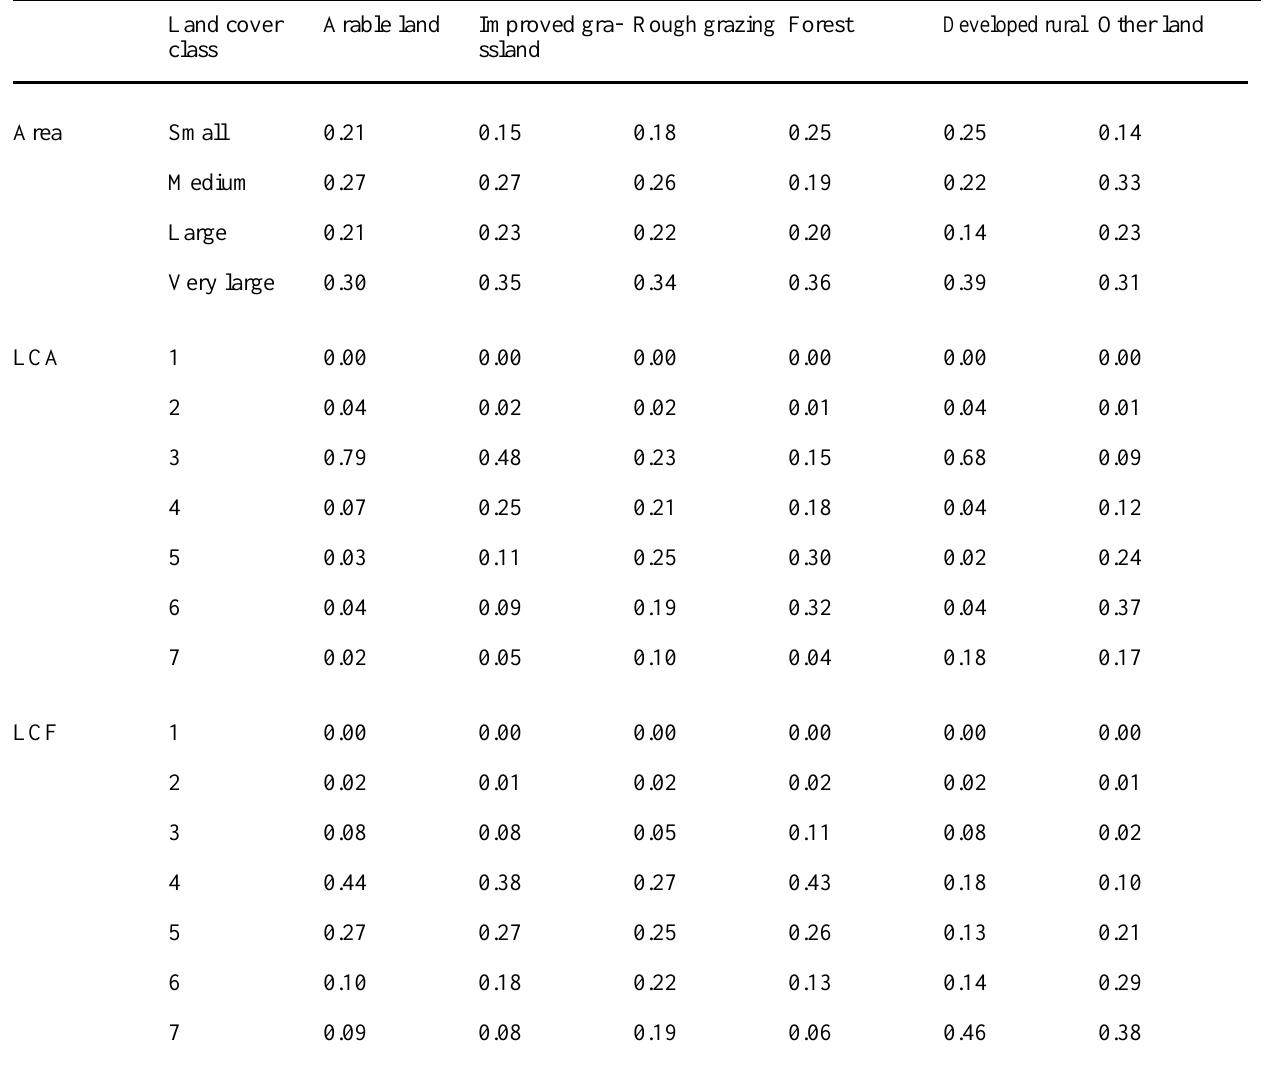
Table 8. Diagnostic inference—the probability of a land cover for particular site characteristics. Land cover